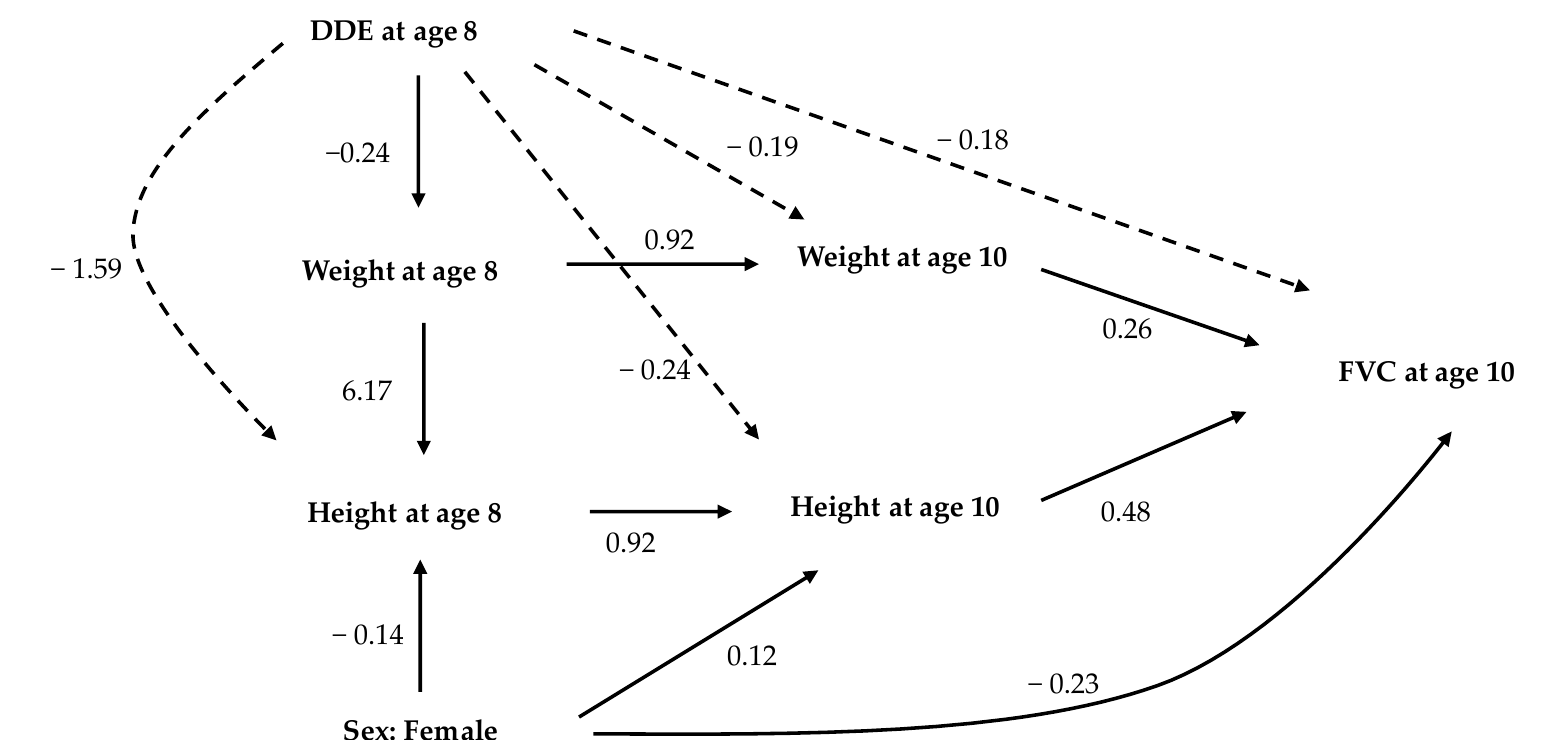
Figure 1. Analytical path model showing statistically significant, standardized, direct, and indirect effects of DDE exposure at eight years of age, height and weight at eight and ten years of age, and FVC at age 10 years. The path coefficients represented by solid arrows are direct effects, while those represented by dashed arrows are indirect effects. Associations with non-significant total effects are not shown in this diagram. Goodness of fit criteria: χ -squared test statistic = 33.1, p -value < 0.05; AGFI = 0.898; CFI = 0.994; RMSEA = 0.048.